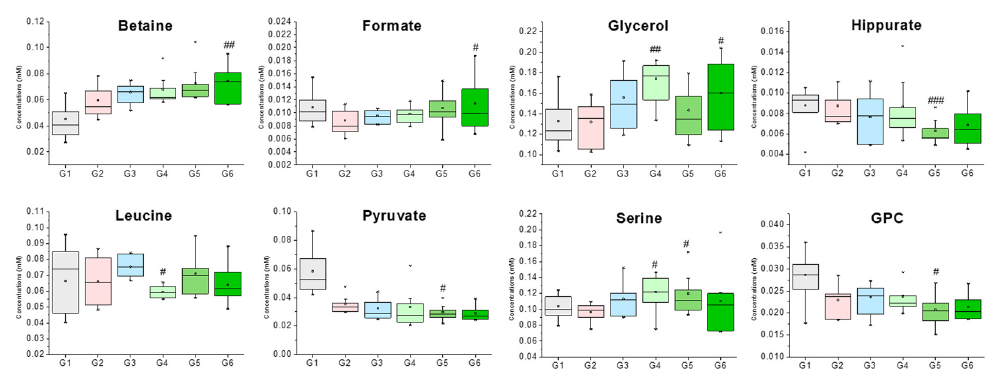
Figure 3. Box plots of metabolites that had groups that were significantly different when compared to G2 (Group 2). ###/##/# indicate significant differences at the p < 0.001, p < 0.01, p < 0.05 levels compared to the G2, respectively.